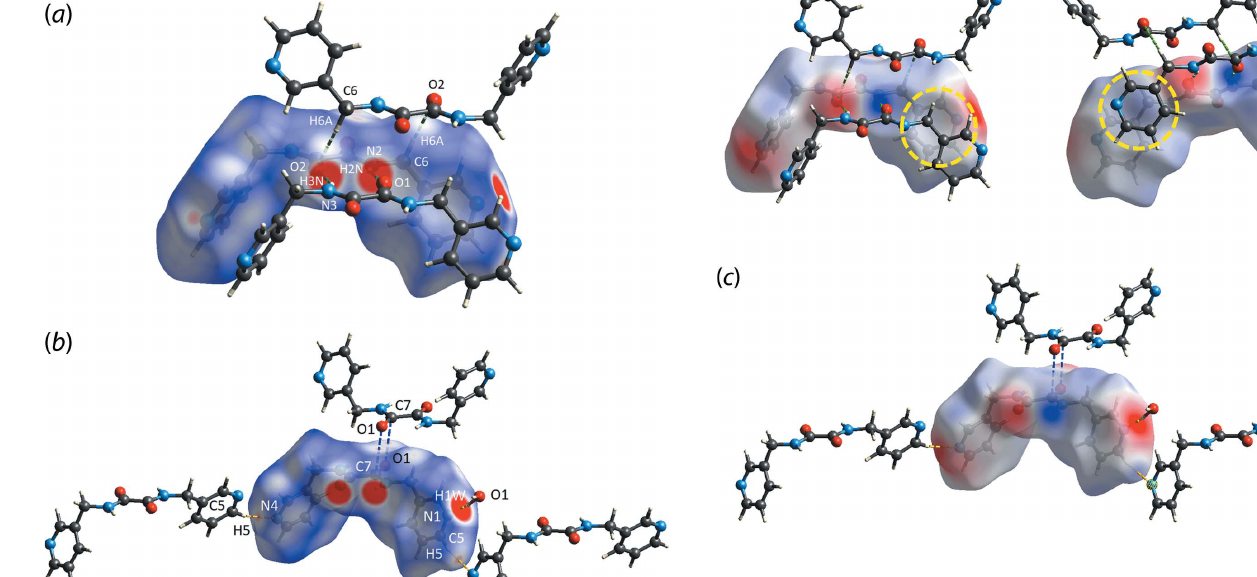
Figure 4 The electrostatic potential mapped onto the Hirshfeld surface within the isosurface value of (cid:5) 0.0964 to 0.1012 atomic units for 3 L H 2 in (I), showing the charge complementarity for ( a ) C6—H6 A (cid:2)(cid:2)(cid:2) O2 (green dashed lines), ( b ) N2—H2 N (cid:2)(cid:2)(cid:2) O1 and N3—H3 N (cid:2)(cid:2)(cid:2) O2 (green dashed lines) and ( c ) C5—H5 (cid:2)(cid:2)(cid:2) N4 (yellow dashed line), O1 W —H1 W (cid:2)(cid:2)(cid:2) N1 (yellow dashed line) and C7 (cid:2)(cid:2)(cid:2) O1 (blue dashed lines) interactions. The yellow circles in ( a ) and ( b ) highlight the dispersive nature of the methylene-C—H (cid:2)(cid:2)(cid:2) (cid:2) (pyridyl) interaction with no charge complemen- tarity.